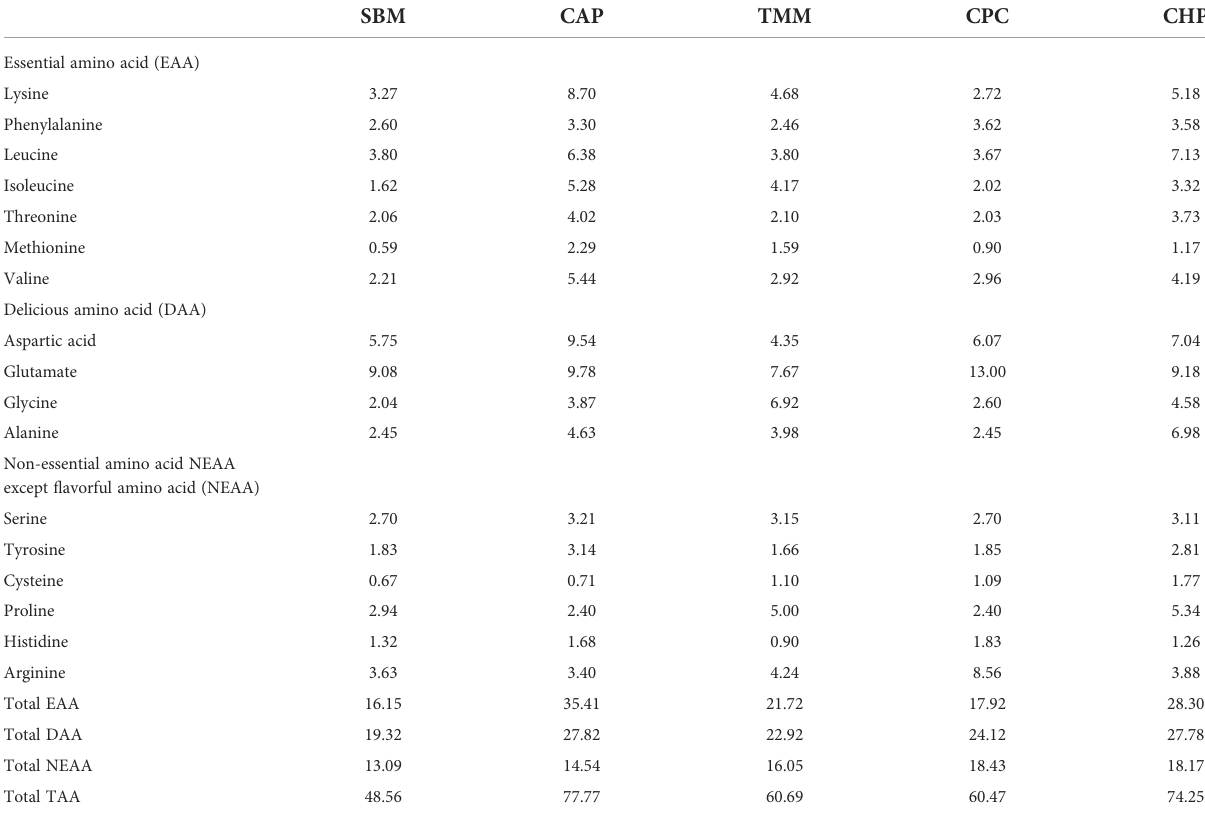
TABLE 2 Amino acid composition of feed (% dry-matter basis). SBM CAP